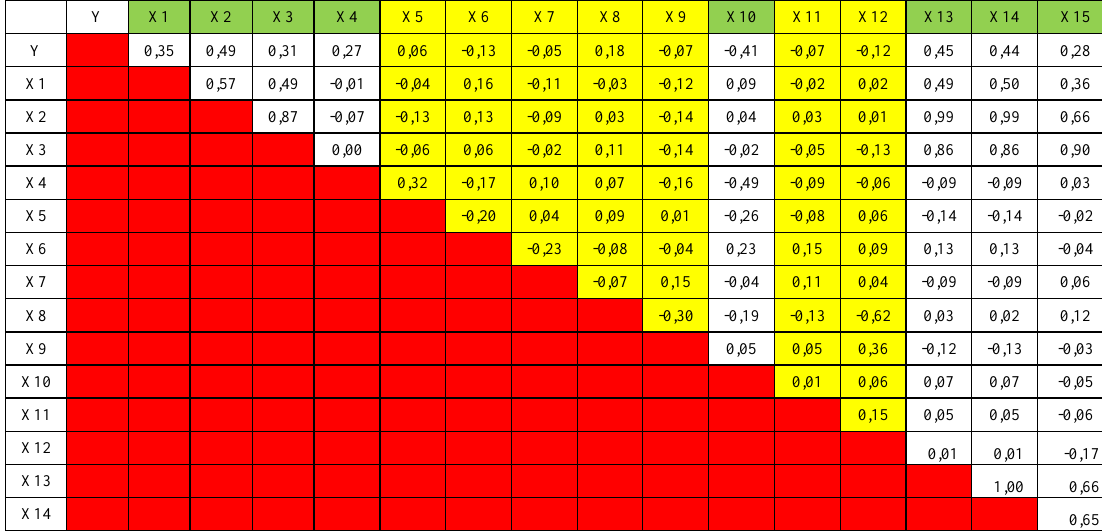
Table 5. Choice of factors, affecting the market value of land underlying industrial facilities by correlation coefficient